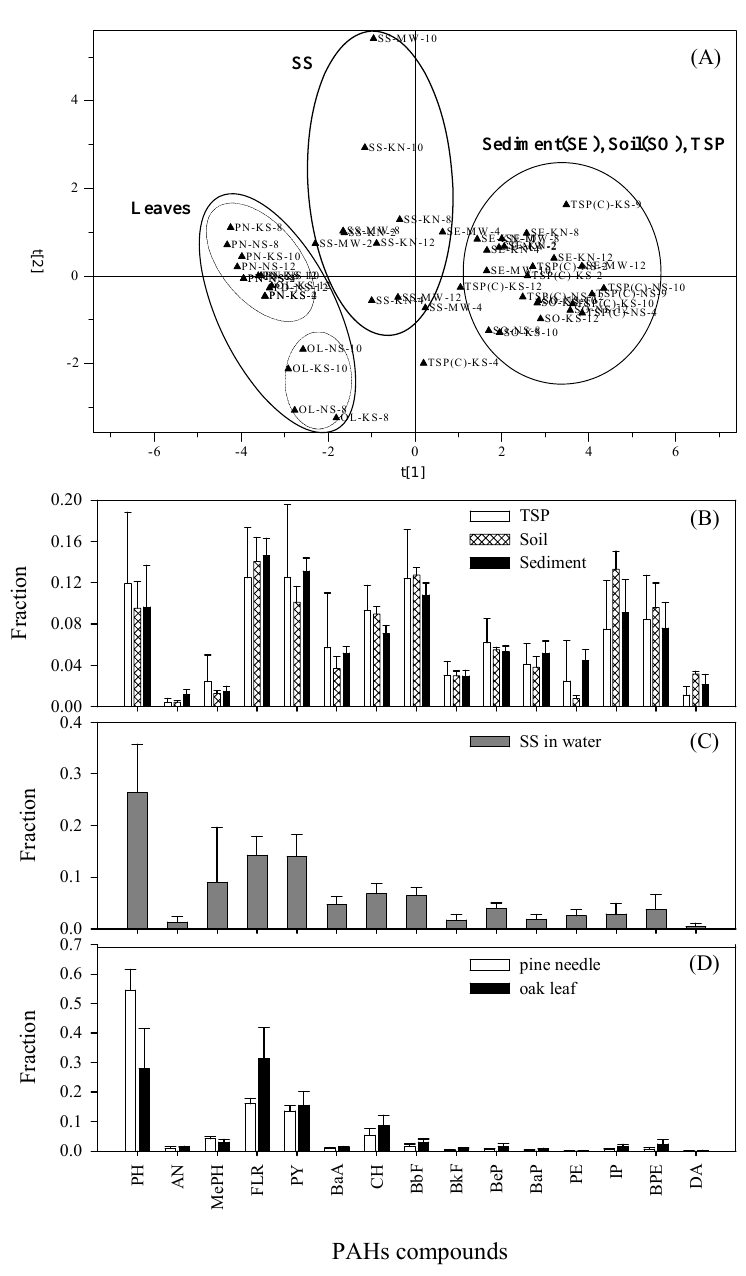
Figure 6. PAH profiles in the environmental solid media. (A) grouping of the PAHs (C) profile in SS (NA: not analyzed), and (D) profiles in the leaves. PCA was